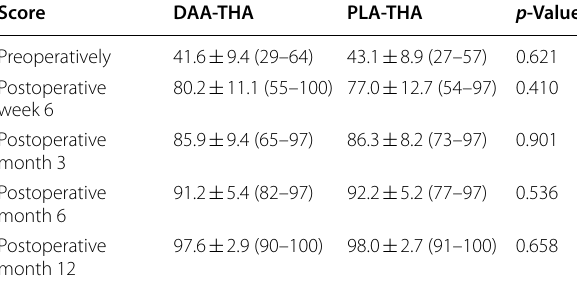
Table 4 HOOS of the two groups